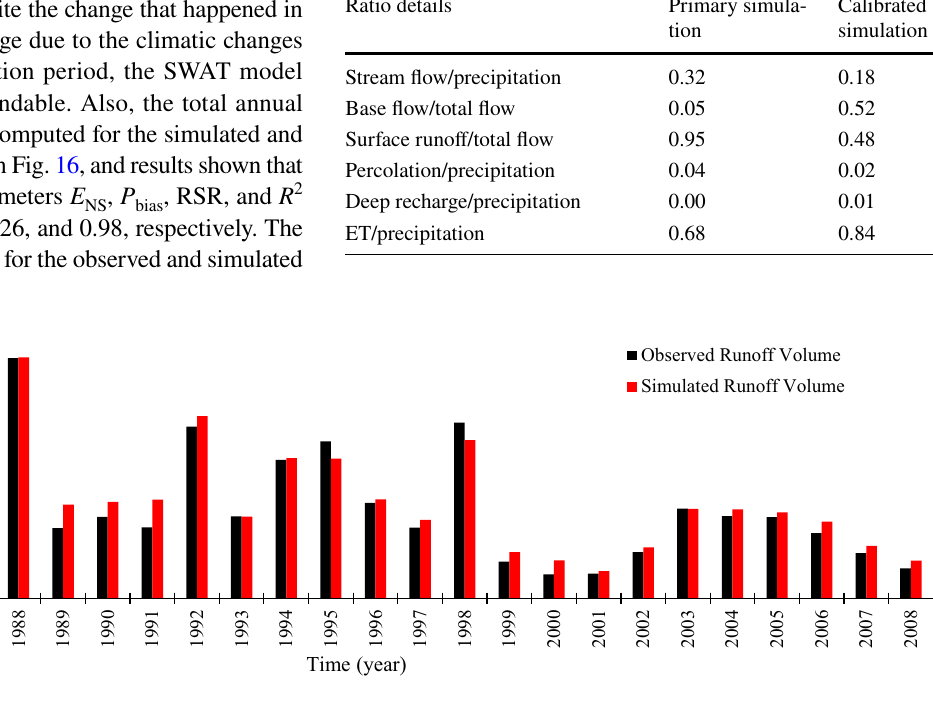
Fig. 16 Annual runoff volume delivered to the Hemren dam reservoir for the period 1983–2008